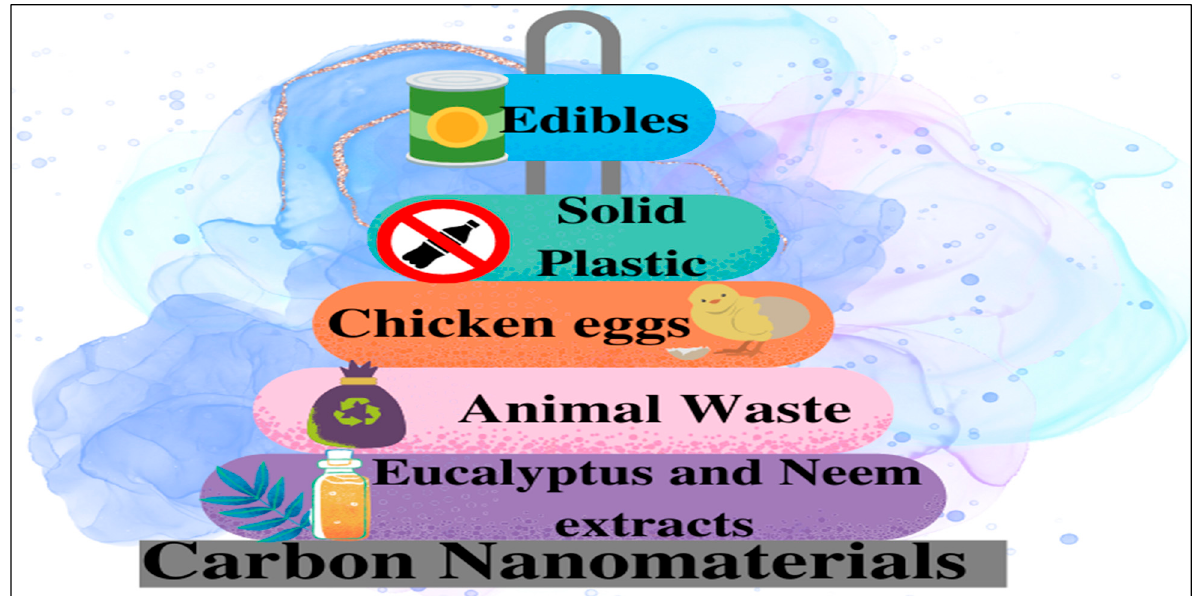
Figure 7. For the manufacture of various novel revolutionary carbon nanostructures, various natural precursors, widely used.